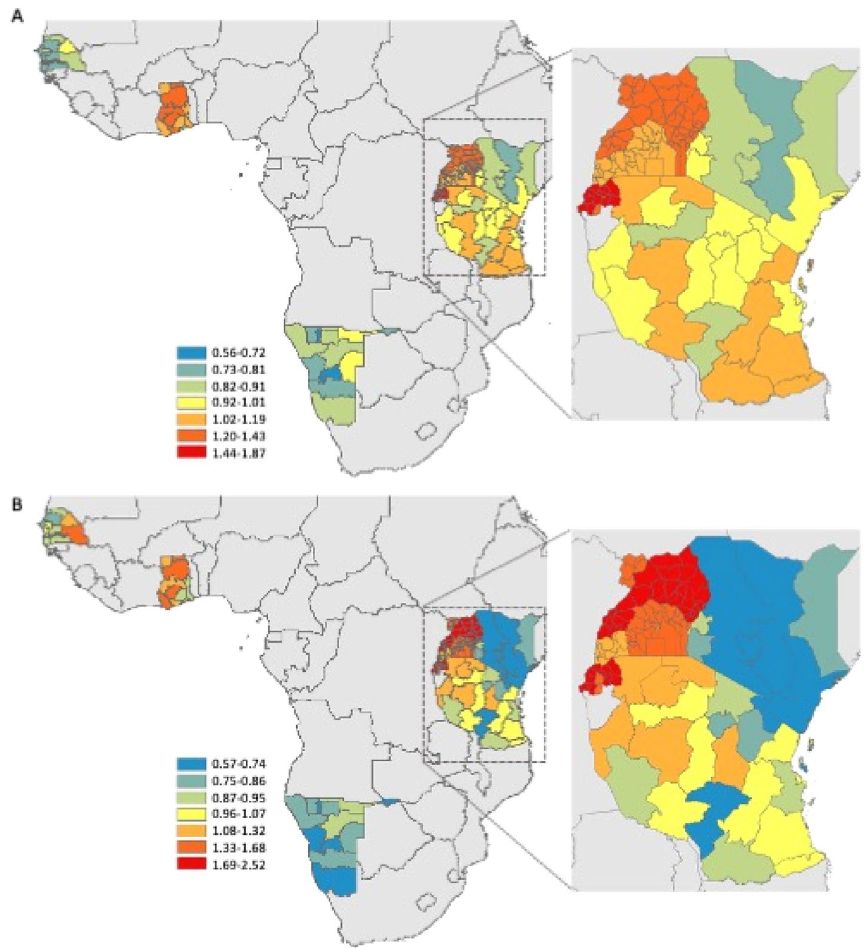
Figure 2. Map of study area with estimated hazard ratio for ( A ) child and ( B ) infant mortality per region averaged over the study period relative to the median value. East Africa is enlarged (inset) to better appreciate the inter and intra-country differences in risk of death. Maps were generated in ArcMap 10.7 (Esri Inc., 2019, https:// deskt op. arcgis. com/ en/